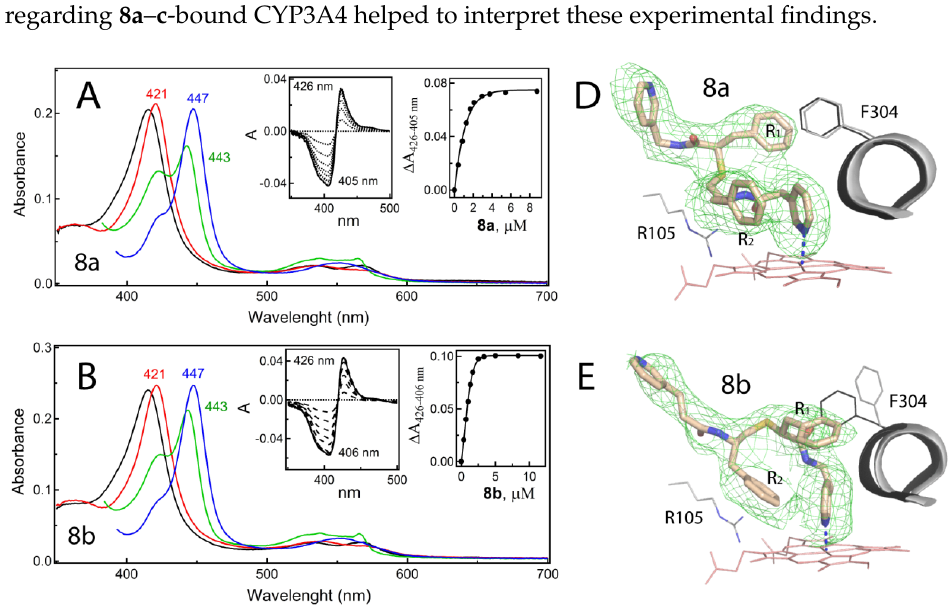
Figure 5. Spectral properties and the binding modes of 8a − c . ( A − C ) Ligand-induced spectral changes in CYP3A4. Absorbance spectra of ferric ligand-free and inhibitor-bound CYP3A4 are in black and red, respectively. Spectra of ferrous ligand-bound CYP3A4 and its CO-adduct are in green and blue, respectively. Left insets are difference spectra recorded during equilibrium titra- tions; right insets are titration plots with quadratic fittings. The derived K s values are given in Table 1. ( D − F ) Binding modes of 8a − c observed in the crystal structures. The central portion of the I-helix and Phe304 in the inhibitory complexes and water-bound CYP3A4 (5VCC structure) are depicted in gray and black, respectively. 8a and 8c bind in a reverse mode, with the end-pyridine serving as the heme-ligating moiety. However, the R 1 - and R 2 -phenyl groups (indicated) occupy the same sites. Polder omit electron density maps contoured at 3 σ level are shown as green mesh. The 8a -, 8b -, and 8c -bound structures of CYP3A4 have the PDB ID codes 7UFB, 7UFC, and 7UFD, respectively. 2.4.2. Crystal Structures of 8a -, 8b -, and 8c -Bound CYP3A4 The X-ray structures of CYP3A4 complexed with 8a , 8b , and 8c were solved to 2.25, 2.35, and 2.90 Å, respectively (Tables S1 and S2). The observed ligand orientations are shown in Figure 5D–F. Because 8a − c were not fully symmetrical and differ in the linker carbonyl positions (Figure 2), it was possible to distinguish whether the ligating moiety was the head- or end-pyridine based on the electron density maps. Intriguingly, only 8b coordinated with CYP3A4 via the head-group, while 8a and 8c ligated in the reverse orientation, with the head-pyridine in the substrate channel and the end-pyridine coor- dinated with the heme. However, the R 1 group was still placed at the P1 site and R 2 in the P2 area (Figure 5D–F). Generally, this distorted mode of side-group placement is unfa- vorable and has only been observed in inhibitors with S / R configuration [16,30]. Crystal structure examination showed that, due to the shorter pyridine spacer, 8a could not strongly ligate to the heme, as evident from the longer Fe-N bond (2.29 Å vs. 2.04–2.10 Å for 8b , c ; Table 3). Additionally, in this subset of inhibitors, only 8c could form an H-bond via the carbonyl oxygen to the active site Ser119. Thus, one advantage of the